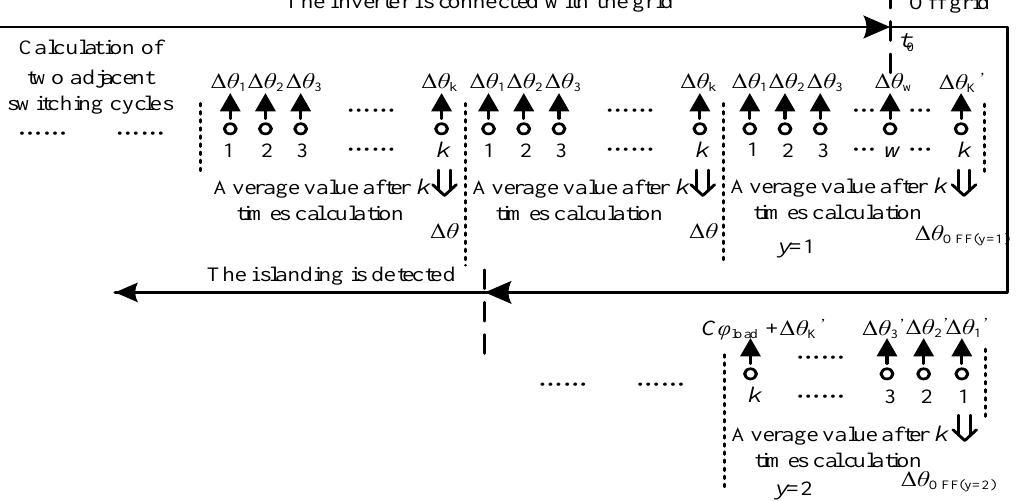
Figure 4. The relationship of Δ θ , Δ θ OFF , and the inverter working conditions.